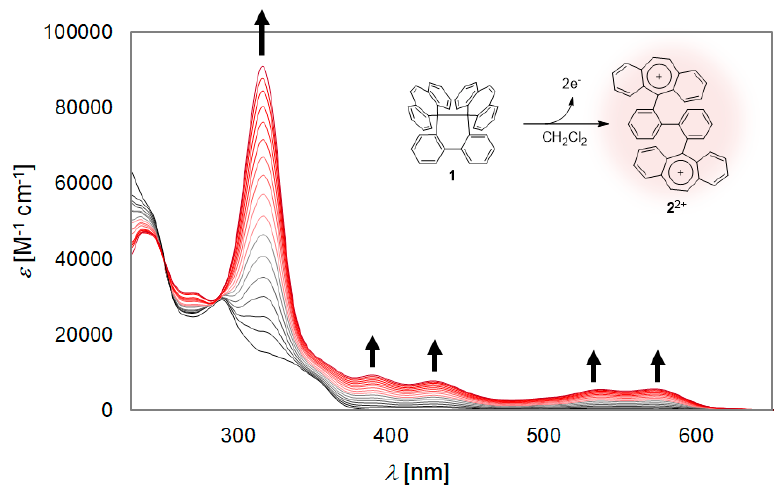
Figure 8. Change in the UV/Vis spectrum upon electrochemical oxidation (20 µ A) of 1 in CH 2 Cl 2 containing 0.05 M Bu 4 NBF 4 as a supporting electrolyte (every 4 min).